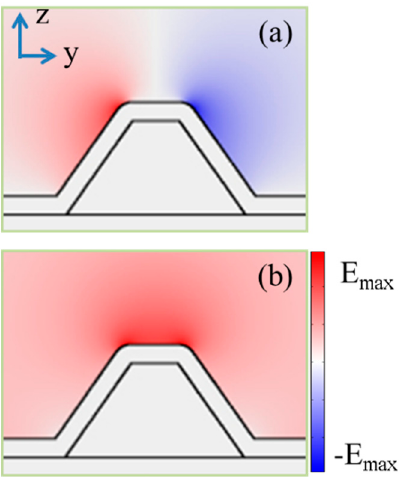
Figure 4. The electric field distribution of the fundamental propagation mode on the cross–section of a trapezoidal-shaped SPP waveguide: ( a ) E y electric field component and ( b ) E z electric field component.